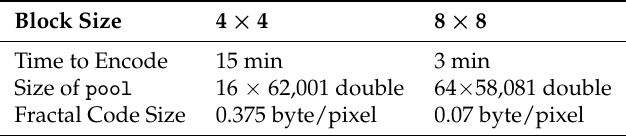
Table 2. Fractal image representation of the 256 × 256 Cat image with range block size of 4 × 4 and 8 × 8, respectively, with fractal encoder running in MATLAB R2016b on an MS Windows 7 PC with Quad Core Xeon E5520 @ 2.27 GHz and 8 GB RAM. The fractal domain pool is computed with the pixel location of the top left hand corner of the matched domain block being stored as 8-bit